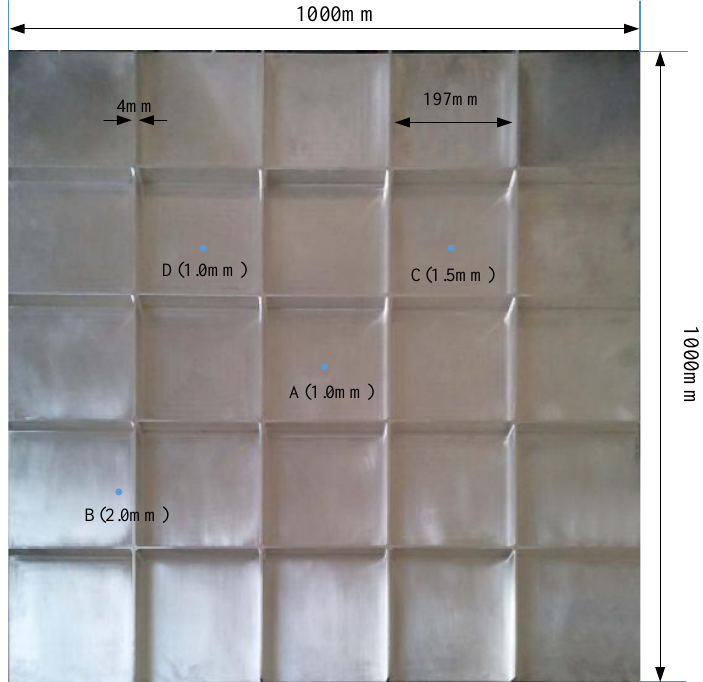
Figure 11. The test plate.